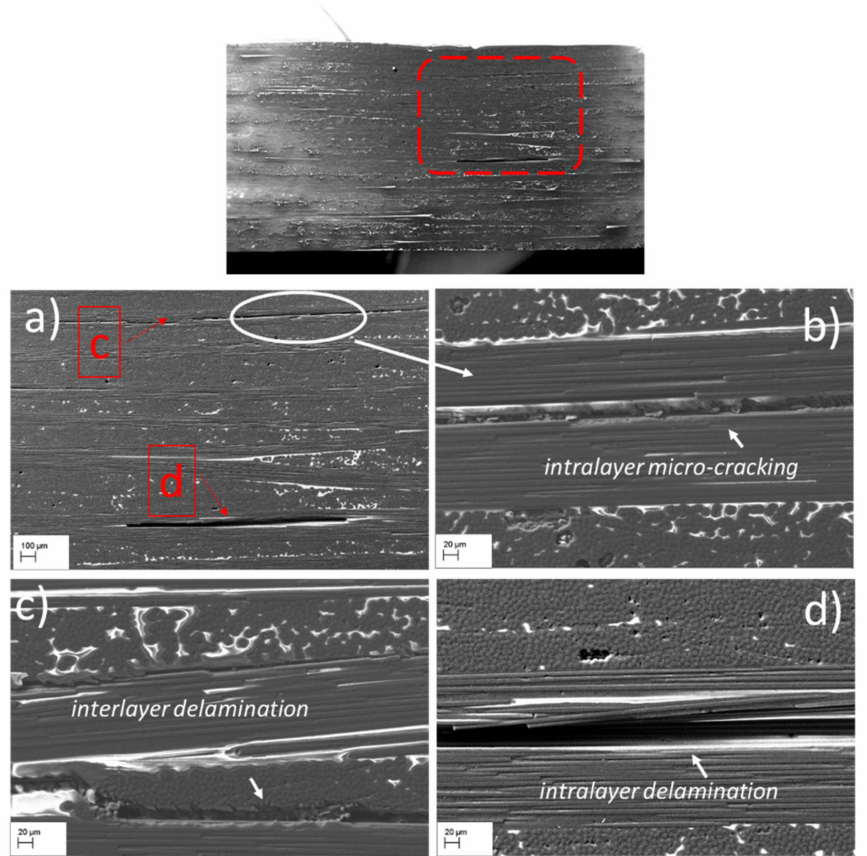
Figure 5. SEM macrograph of the SBS_100 sample cross section: ( a ) enlarged image of the red spot fringe; ( b ) high magnification SEM images showing intralayer micro-cracking; ( c ) high magnification SEM images showing interlaminar delamination; ( d ) high magnification SEM images showing large intralayer delamination between fibre tows parallel to shear